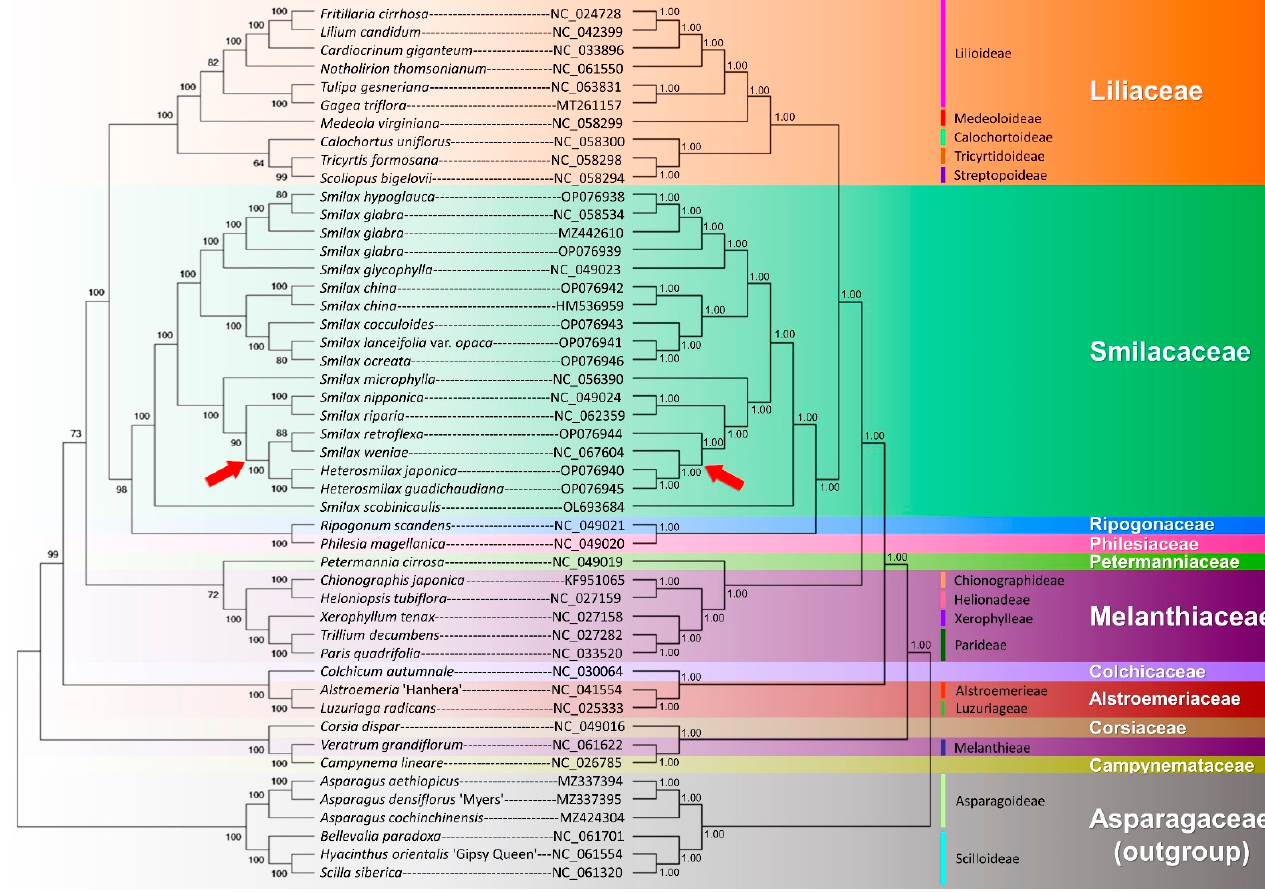
Figure 9. Phylogenomics analysis of forty-two Liliales cpGenomes. Six cpGenomes of Asparagales- Asparagaceae were selected as the outgroups. ML tree on the left. BI tree on the right. The bootstrap percentage (BP) and posterior probability (PP) are shown next to the nodes of the branches in the ML and BI trees, respectively. The right side of the BI tree presents the classified subfamilies (if stated) and families sensu APG IV for each accession. The arrows highlight the topological difference of the clade in the ML and BI trees.